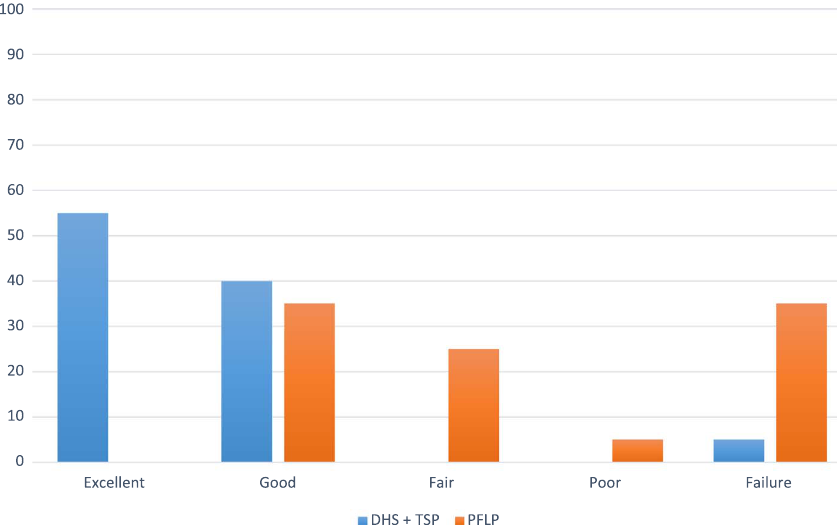
Figure 3. Comparison of Harris hip scores and Failure rate at 1 year between the two groups (in percentages).